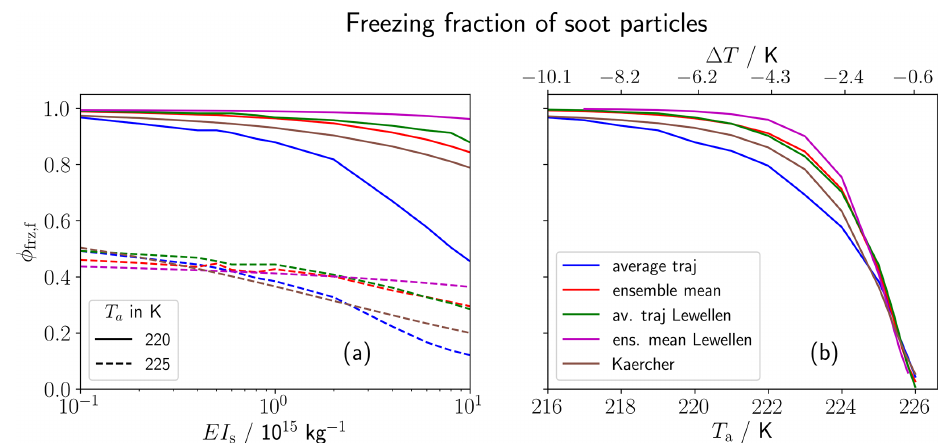
Figure 7. Final freezing fraction of soot particles against (a) soot number emission index and (b) ambient temperature (where the axis on top additionally shows the temperature difference to the SA threshold (cid:49)T ). We juxtapose the original FLUDILES trajectory ensemble (red) with the sped-up ensemble (magenta), whose average dilution matches that of Lewellen (2020). The blue and green lines show the corresponding average traj evolution of both ensembles. Additionally, the results from the parameterization of Kärcher et al. (2015) with an adaption regarding the calculation of the activation dry core radius of soot particles (brown) are